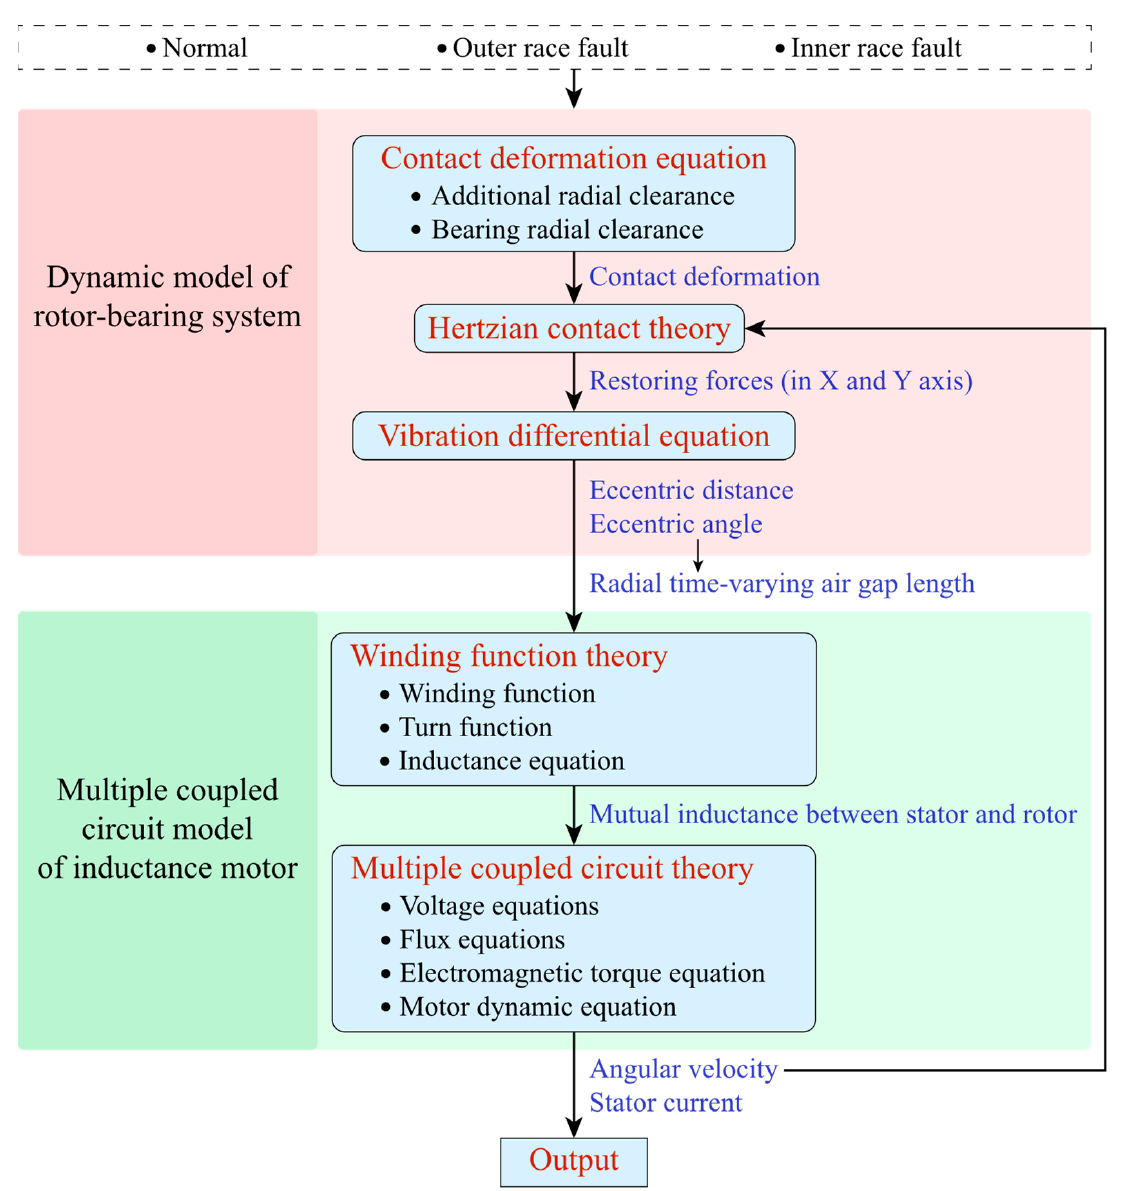
Figure 12. Block diagram of electromagnetic–dynamic coupled model.